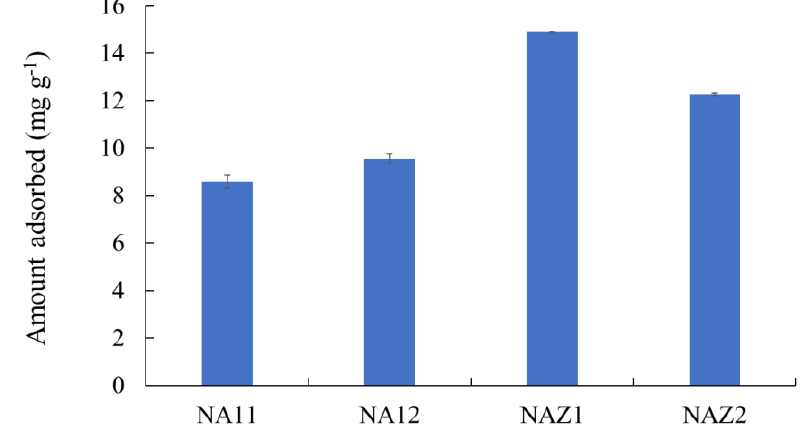
Figure 3. Amount of As(III) adsorbed. Initial concentration: 100 mg L − 1 , solvent volume: 50 mL, adsorbent: 0.1 g, contact time: 24 h, temperature: 25 °C, agitation speed: 100 rpm.